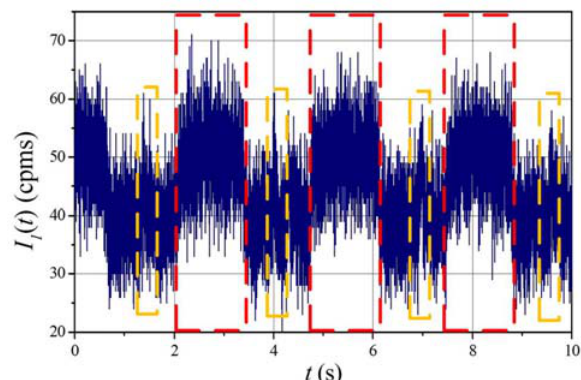
Fig. 4. The first 10 s of signal registered for the described experiment. Red frame indicates the signal coming from the flow of large air bubbles, and an orange frame from smaller structures.